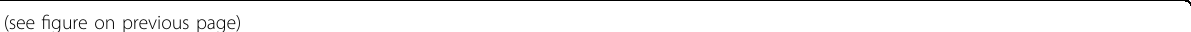
Fig. 5 Validation of gene expression levels and targets of miRNAs in the Hippo signaling pathway network. a Relative expression levels of genes involved in the network as determined by using Q-PCR. The expression fold change is relative to day 0 in GM culture. b Scatter plot showing the general RNA-seq and Q-PCR results. The x -axis shows the values obtained by Q-PCR, and the y-axis shows the values obtained by RNA-seq. c Validation of interactions between miRNAs and their putative target genes. The relative luciferase activities were measured after cotransfection of BHK-21 cells with psiCHECK-2 constructs that contained putative binding sites or the corresponding mutated binding sites in the 3 ′ -UTRs of potential target genes and either miRNA mimics or negative control (NC) for 24 h. * p < 0.05; ** p <